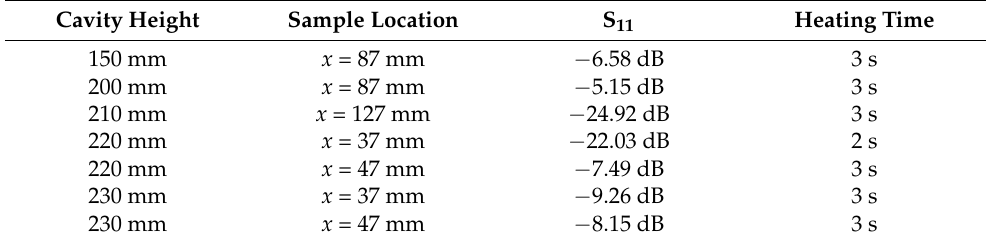
Table 7. The select heating locations and heating time of distilled water.